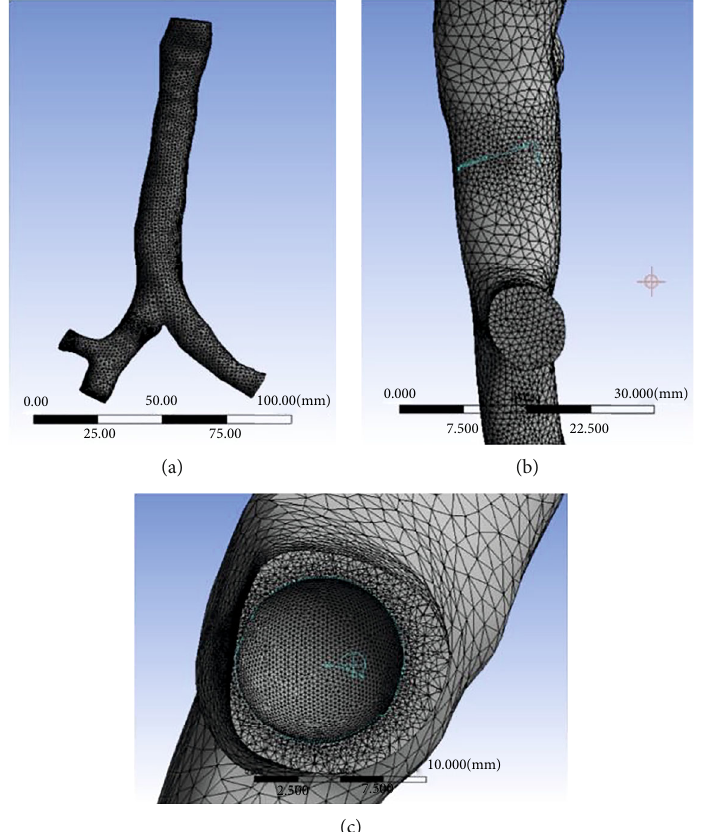
Figure 2: Diagram of the trachea and foreign body mesh model. (a) The frontal tracheal mesh model. (b) The side of tracheal mesh model. (c) Foreign body mesh model.